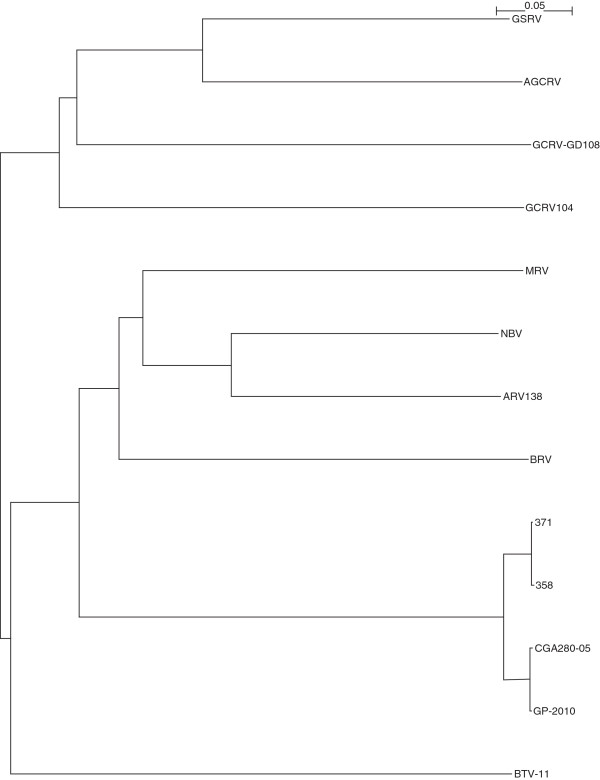
Phylogeny of homologous segment M2 shared by piscine reovirus (PRV) and selected members of familyReoviridae.